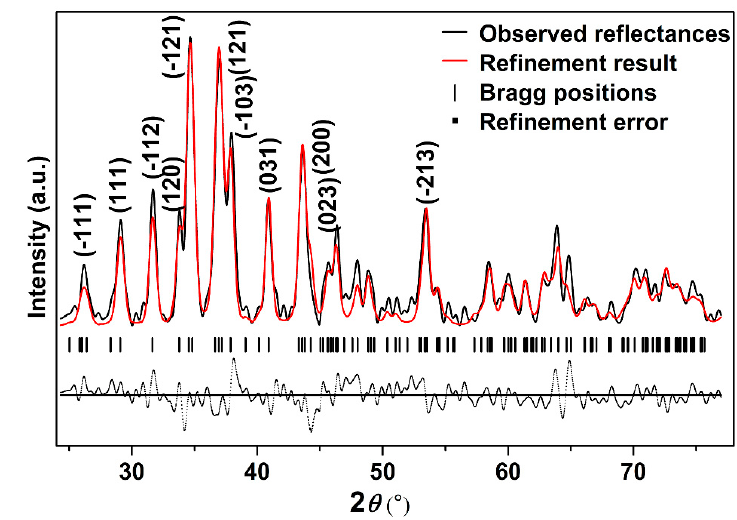
Figure 2. The typical X-ray powder diffraction (XRD) pattern of Ag 2 S nanosheets under ambient conditions; Rwp = 0.3133, Rp = 0.2028, and chi^2 = 84.89.